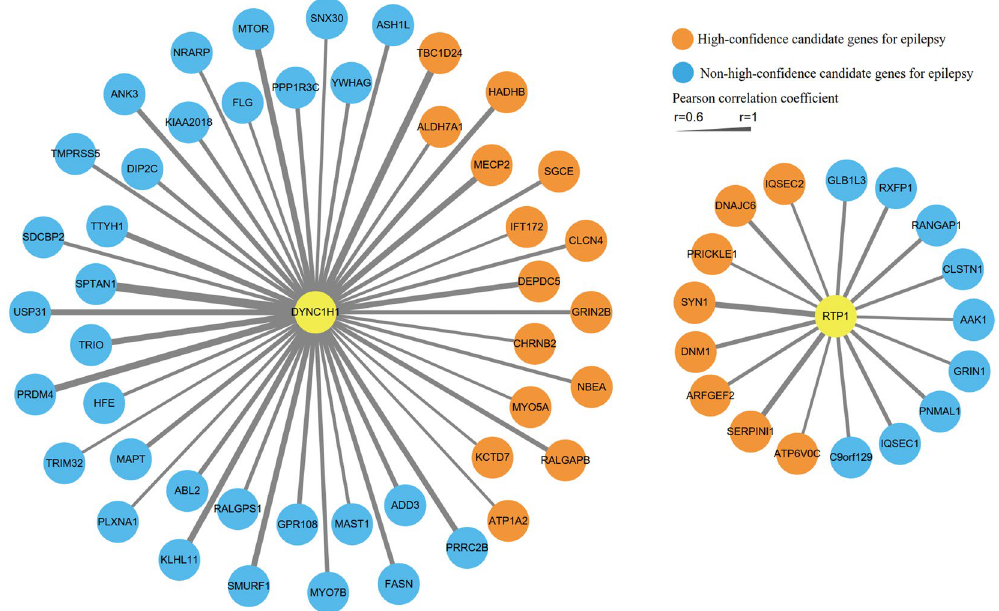
Figure 3. Co-expression network analysis of DYNC1H1 and RTP1 . Gene co-expression levels were estimated using the Pearson correlation coefficients (r) between each pair of genes. Candidate epilepsy genes were extracted from the EpilepsyGene